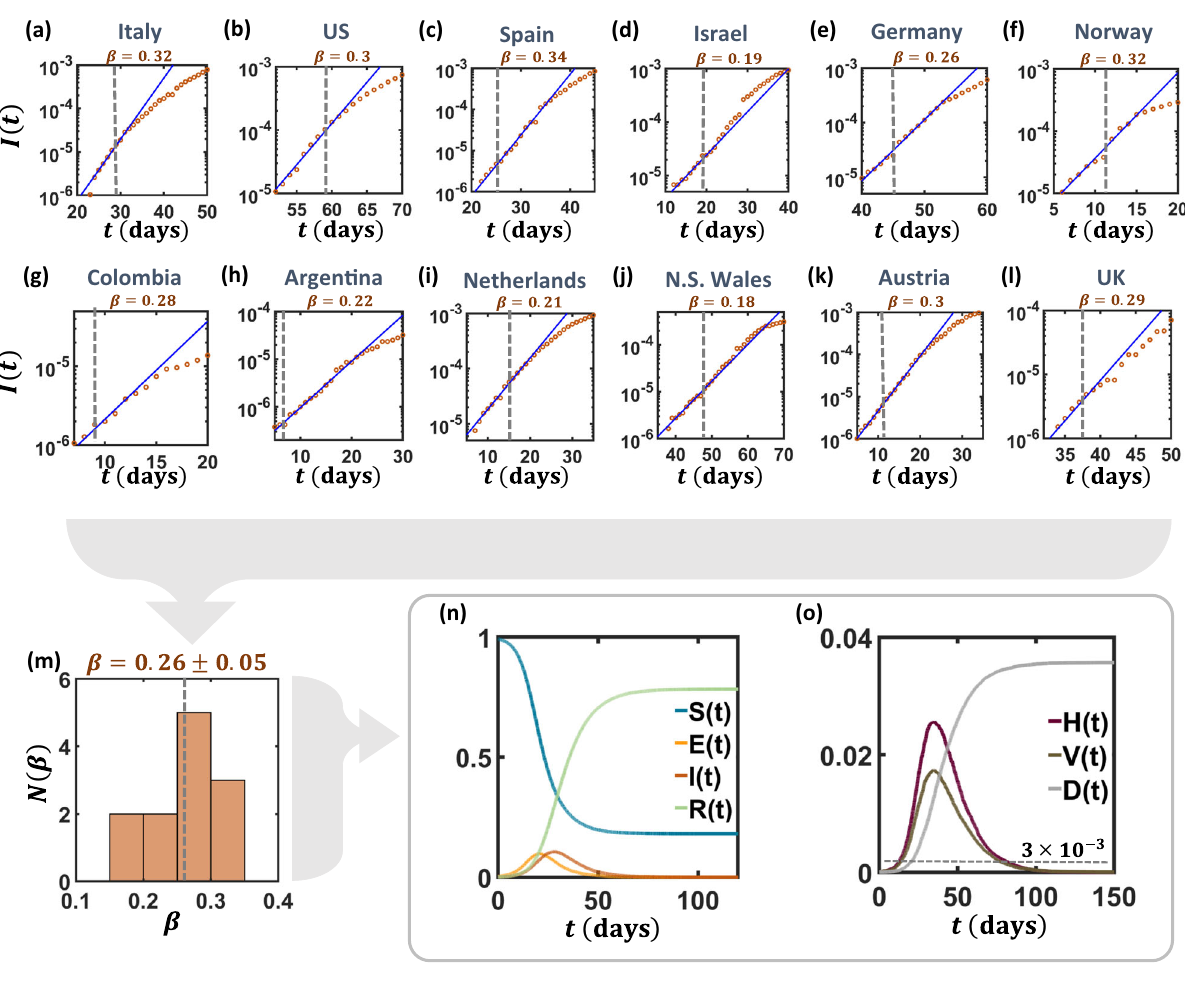
Fig. 3 Extracting the SARS-CoV-2 infection rate. a – l We collected data 38 on the infection levels I ( t ) vs. t (orange circles) in 12 different countries. Fitting I ( t ) to an exponential of the form (1) we evaluate β in each of these countries (blue solid lines). Such exponential growth typically continues for a period of several days posterior to the instigation of a mitigation policy (gray dashed lines). We, therefore, used only the data up to 3 days after the implementation of social distancing to evaluate β (Supplementary Note 4.2). m Histogram of inferred β values across the 12 countries. Infection rates are distributed around an average of β = 0.26 days − 1 . Hence, in our simulations, we tune the parameters to obtain this growth rate under the absence of all prophylactic measures. In reality, standard behavioral practices, such as personal hygiene or avoidance of physical contact, may push β to lower values. To capture this, in our simulations we incorporate three scenarios: worst-case — β ≈ 0.26, intermediate case — β ≈ 0.2 and best case — β ≈ 0.15. n Taking β ≈ 0.26 we simulated the projected evolution of the COVID-19 pandemic alà Figs. 1 and 2, without any preventive measures. o We focus on three crucial parameters that characterize the severity of the projected spread: mortality D ( t ) (gray), hospitalization level H ( t ) (purple), and the number of individuals requiring ventilation V ( t ) (brown). Absent any intervention, H ( t ) exceeds, by a large margin, the average national hospitalization capacity (dashed gray line), estimated at 3 × 10 − 3 43 . Results represent an average of over 20 stochastic realizations on a network comprising 4000 households (~10 4